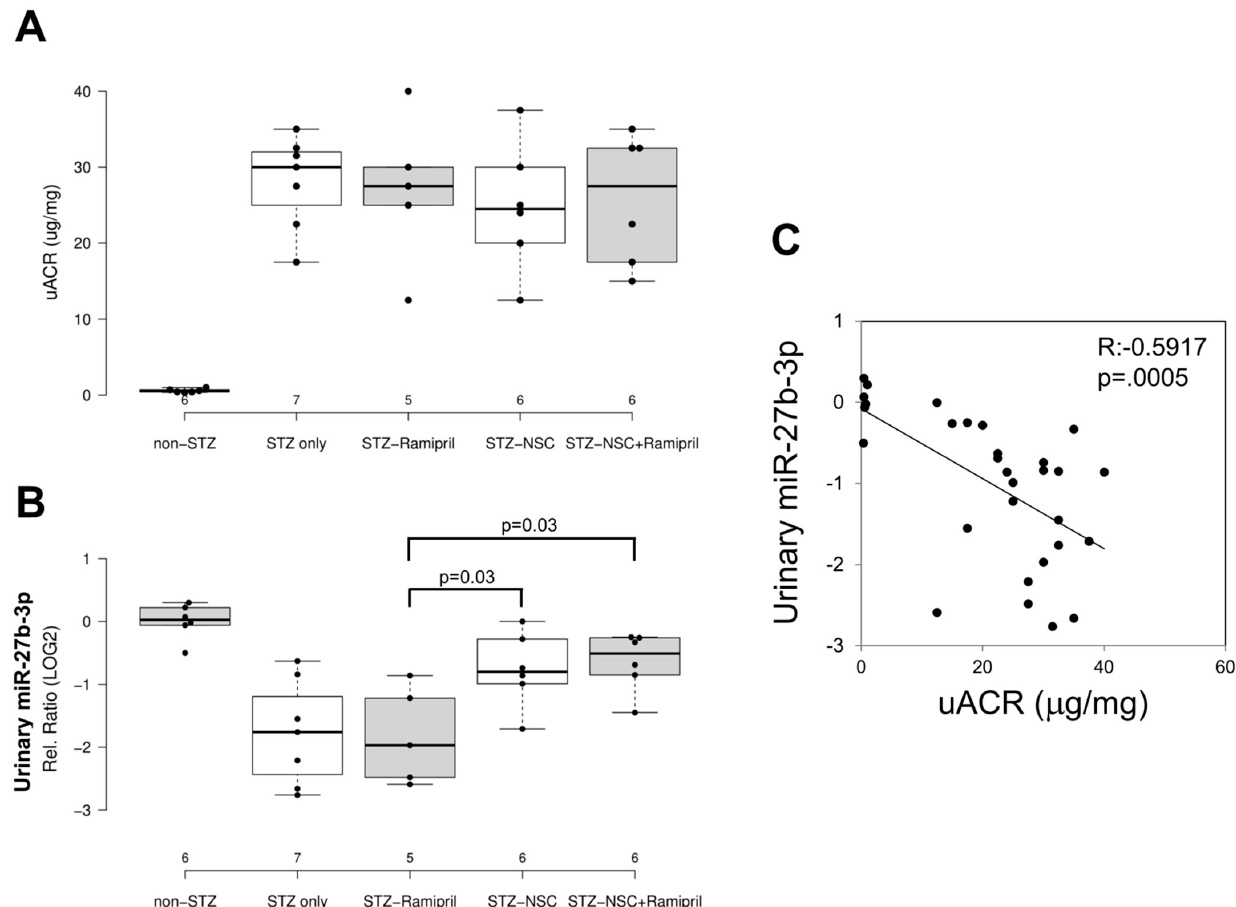
Figure 4. Effects of NSC697923, alone and in association with ramipril, on uACR ( A ) and urinary miR-27b-3p levels ( B ) and correlation among both ( C ). ( A ) Boxplot depicting urinary albumin to creatinine ratio excretion in non-diabetic animals (non-STZ), untreated diabetic animals (STZ-only), diabetic animals treated with ramipril (STZ-Ramipril), diabetic animals treated with NSC697923 (STZ-NSC), or diabetic animals treated with both ramipril and NSC697923 (STZ-NSC + Ramipril). Number of mice analyzed is reported in the graph. Error bars indicate standard deviation. ( B ) miR-27b-3p expression in DBA/2J urinary samples. RNA samples were isolated from 24 h urines. miR-27b-3p was measured using real-time PCR as described in the Methods; results are depicted as LOG2 in the boxplot and were normalized to the relative levels of the exogenous Cel-39 spike-in. Number of mice analyzed is reported in the graph. ( C ) Correlation between uACR and urinary miR-27b-p. R value and p value are reported in the image.